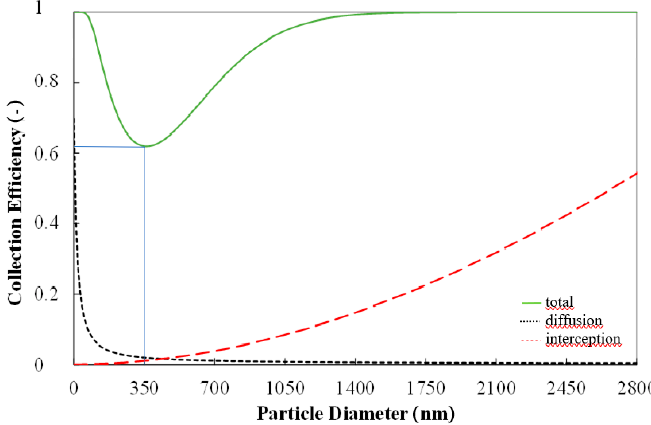
ffi ciency with particle size.